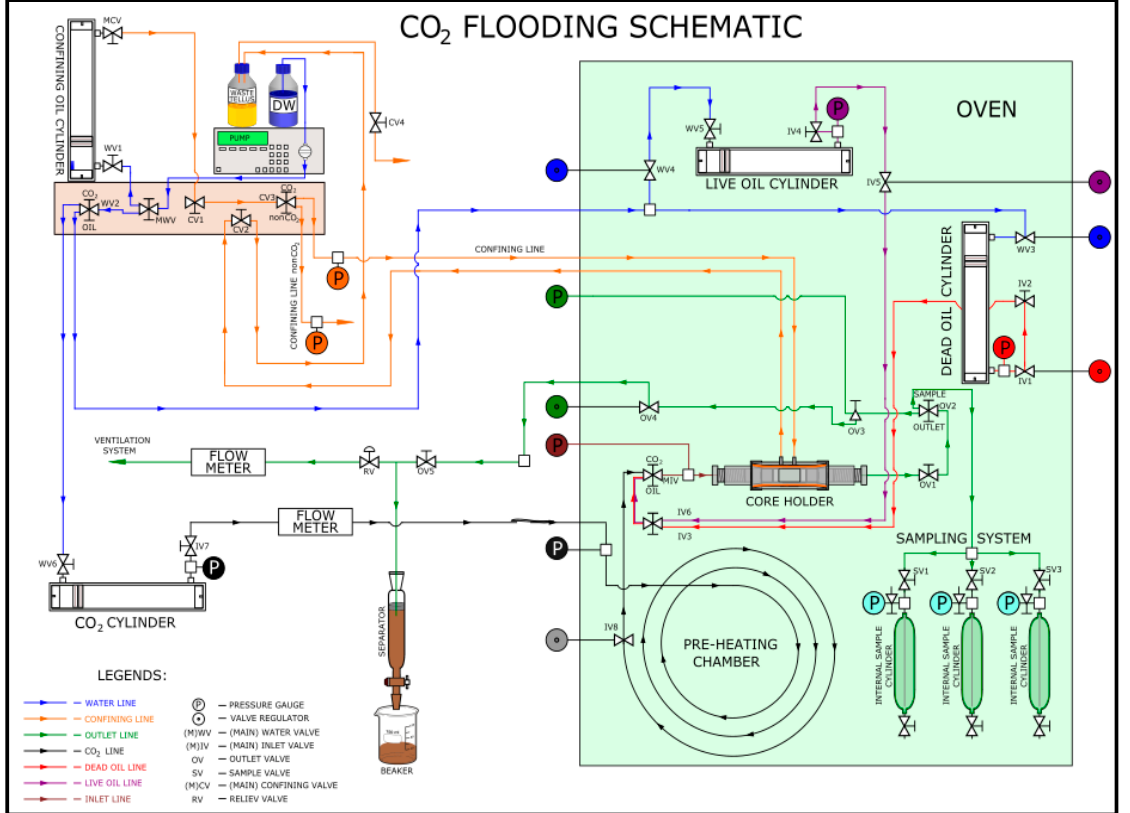
Figure 1. Schematic of the CO 2 flooding system.